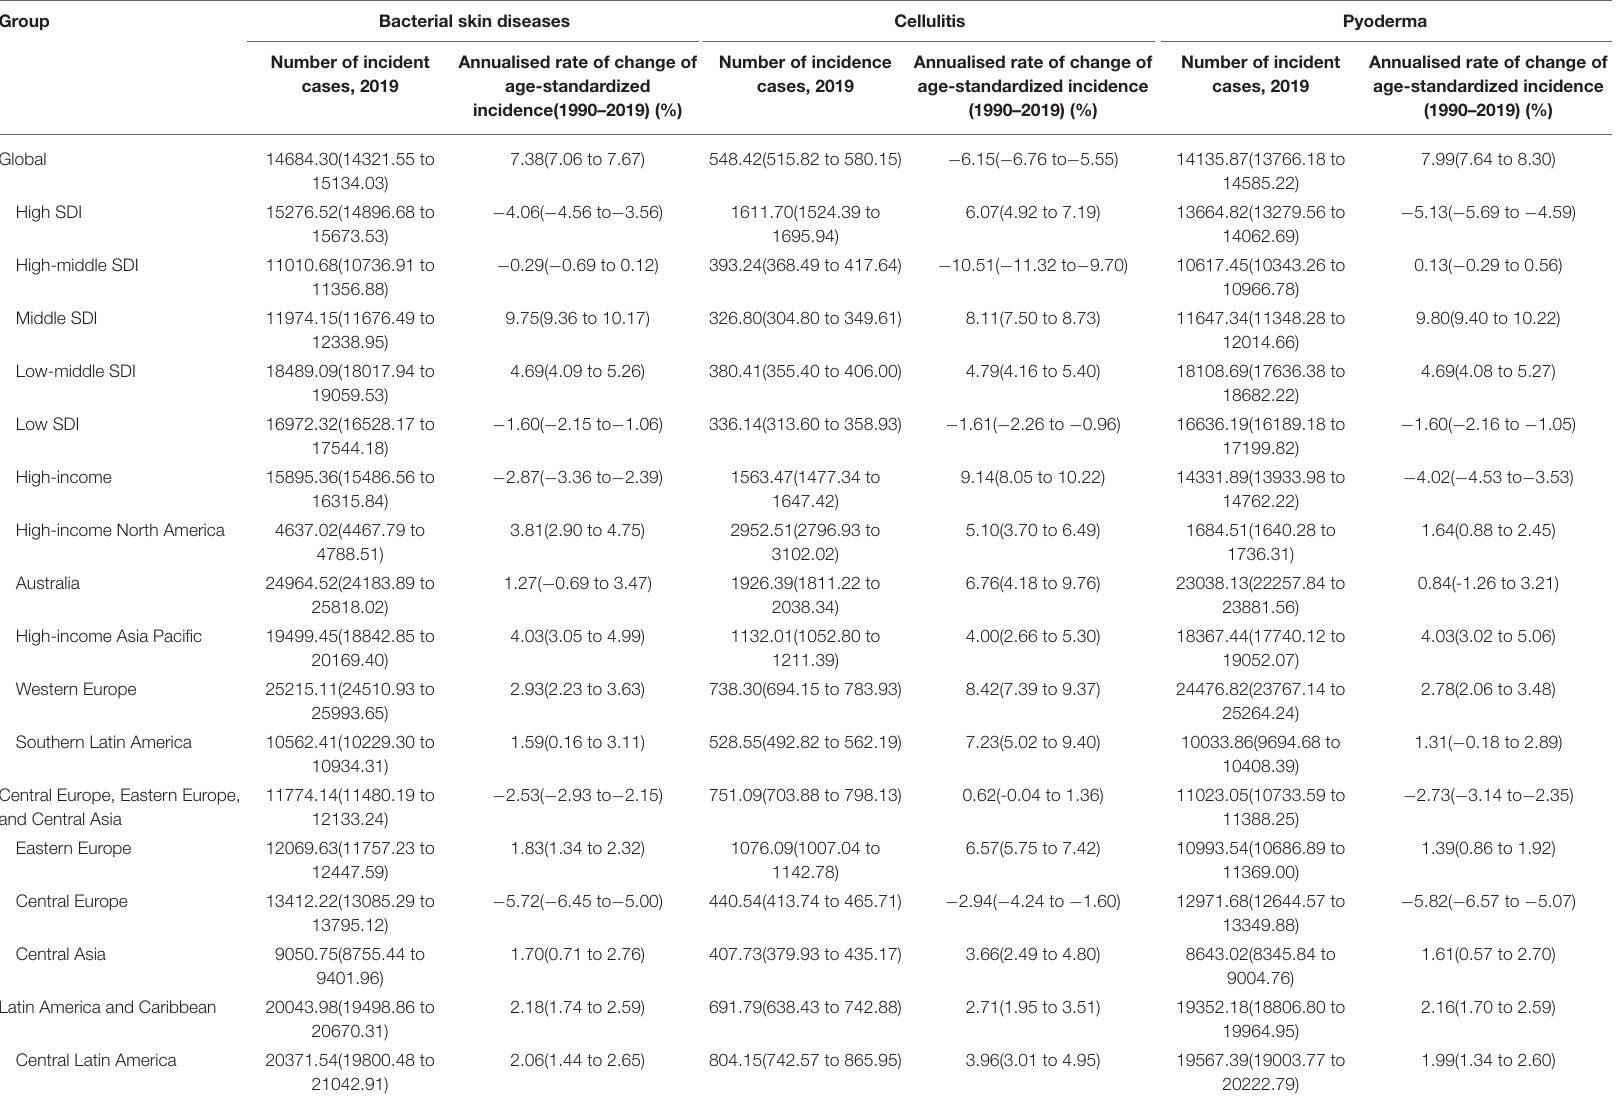
TABLE 1 | Age-standardized incidence rate of major bacterial skin diseases in 2019, and change of age-standardized incidence rate for both sexes (1990–2010 and 2010–2019). Group Bacterial skin diseases Annualised rate of change of